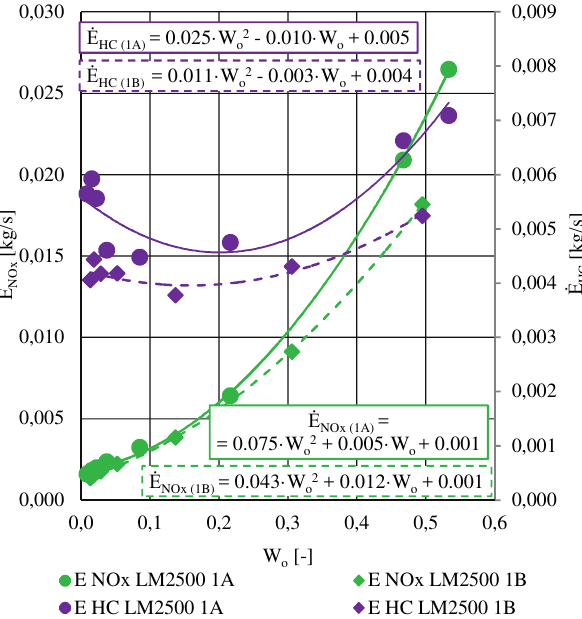
Fig. 10. The mass emission intensity of nitrogen oxides ( E(cid:17) carbons (